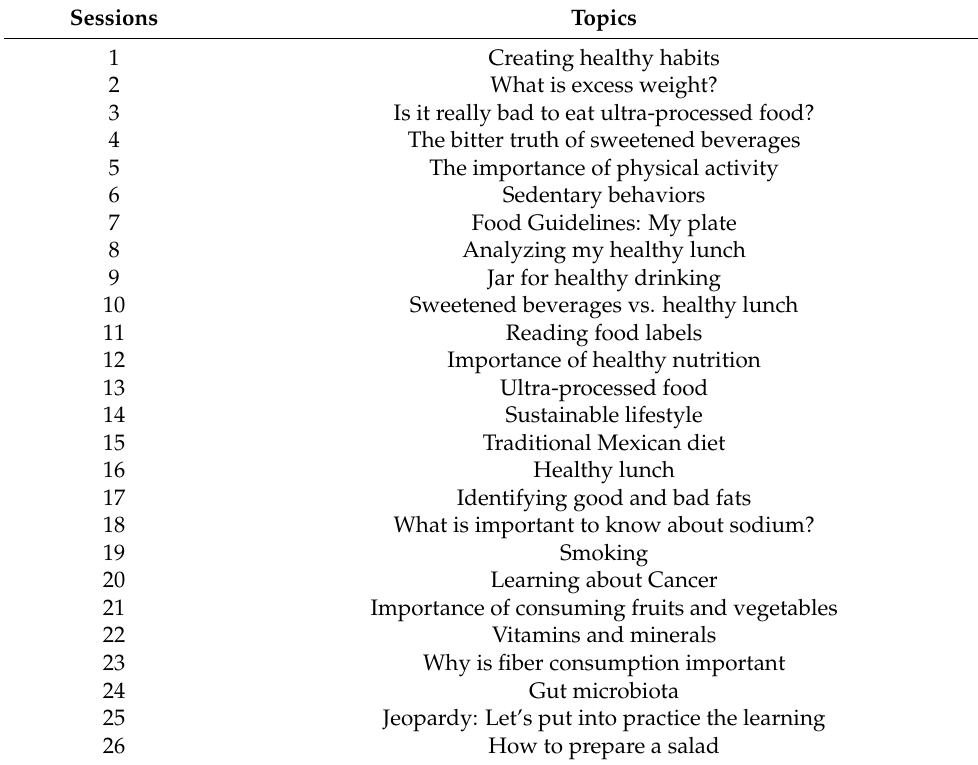
Table 1. Sessions and topics of the “Planet Nutrition”